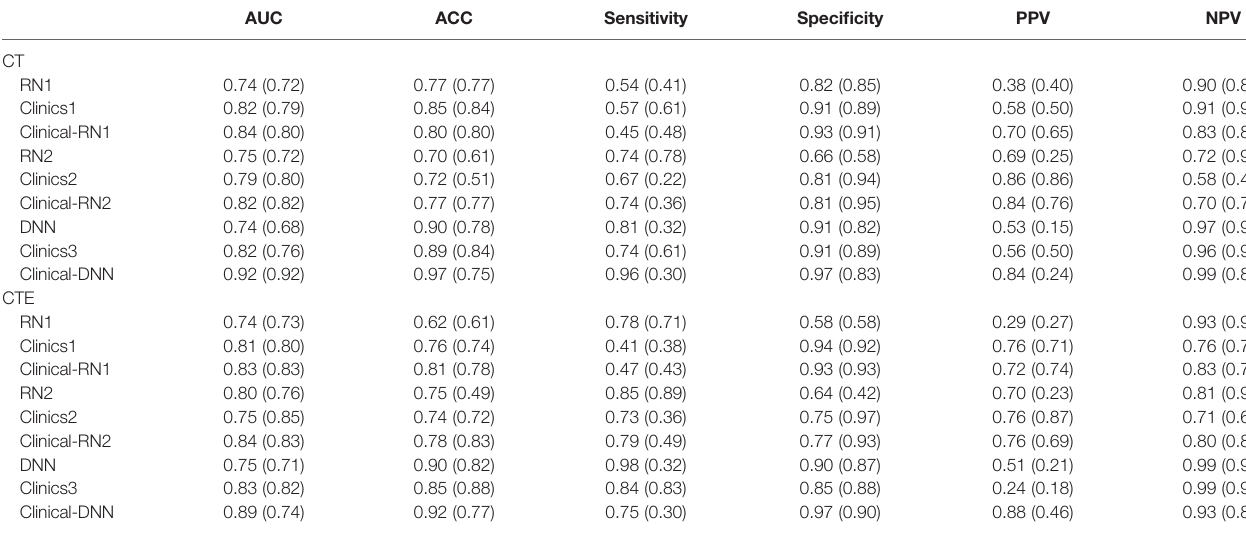
RN, radiomics nomogram; AUC, area under curve; ACC, accuracy; PPV, positive predictive value; NPV, negative predictive value. Training set, in front of the brackets. Validation set, in brackets.